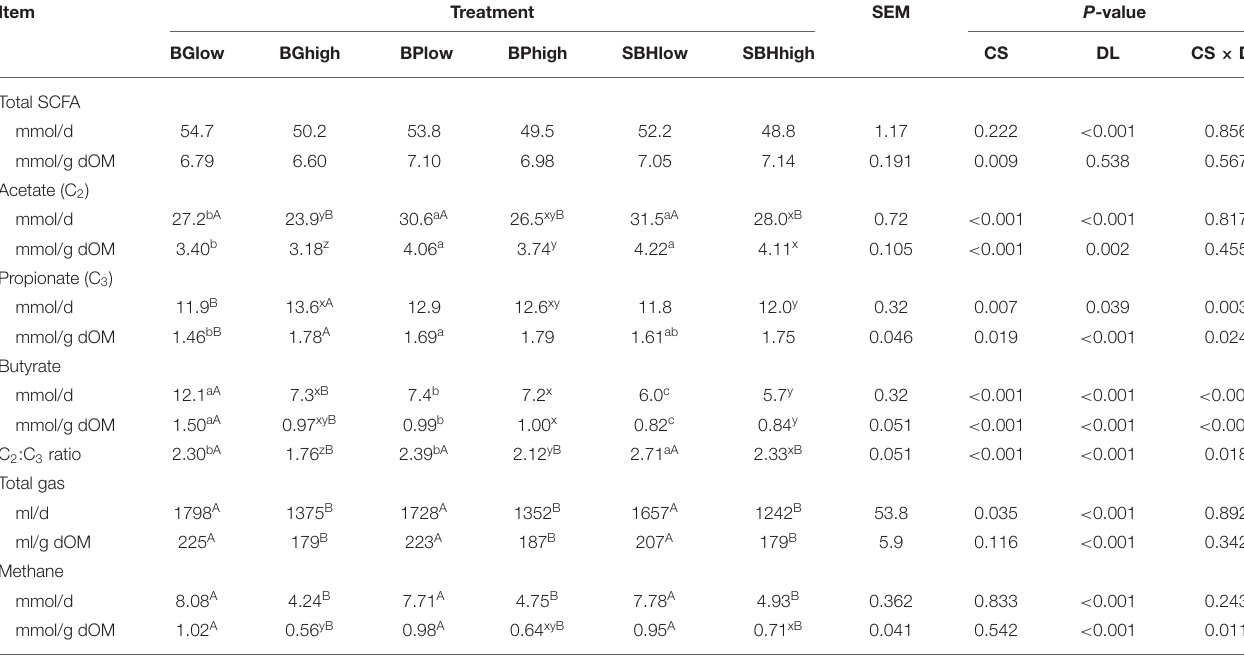
TABLE 4 | In vitro short chain fatty acid (SCFA), methane and total gas production of different carbohydrate sources incubated at high and low dilution rate. Item Treatment